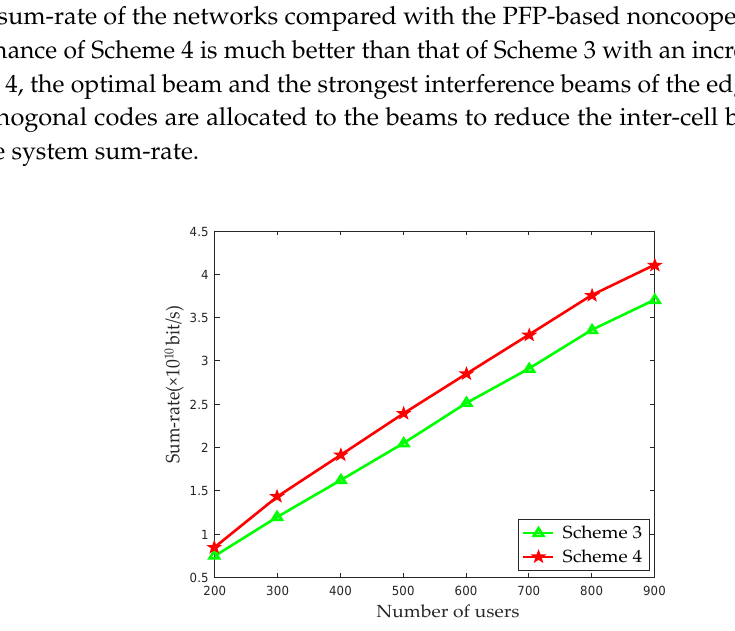
Figure 9. System sum-rate with respect to the number of UEs in